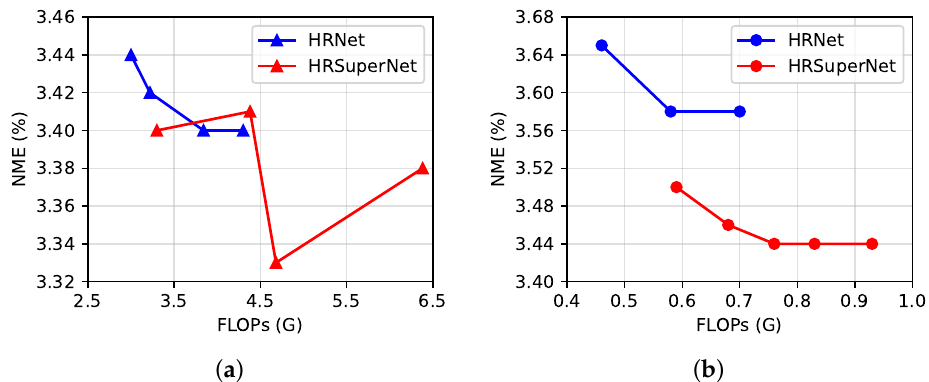
Figure 6. Comparison of HRNet and HRSuperNet based on original residual units ( a ) or stacked MBConvs ( b ), which were used as the supernetwork in the proposed slimming method. We obtained a series of slimmed networks with different NME and FLOPs on the 300W full set by using different pruning thresholds.